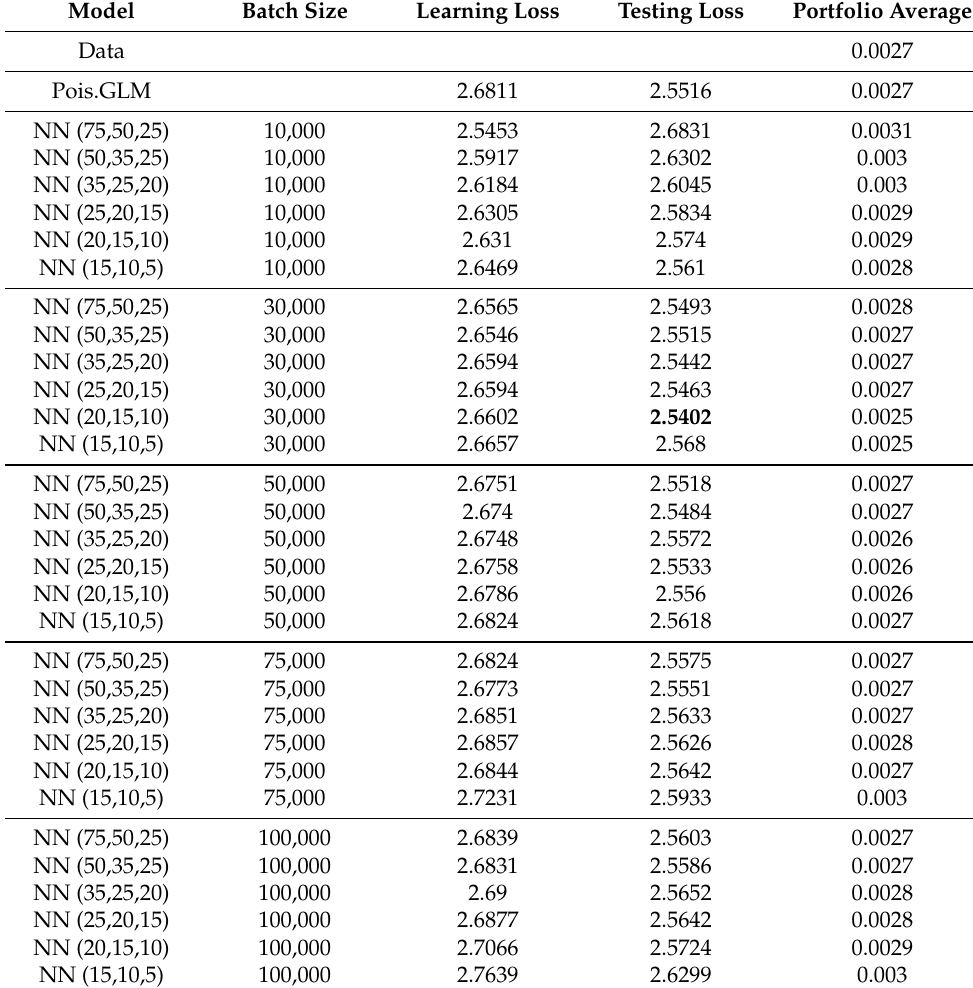
Table A7. The testing loss, learning loss, and portfolio average of the Poisson neural network models with different architectures for 10,000, 30,000, 50,000, 75,000, 100,000, and 175,000 batch